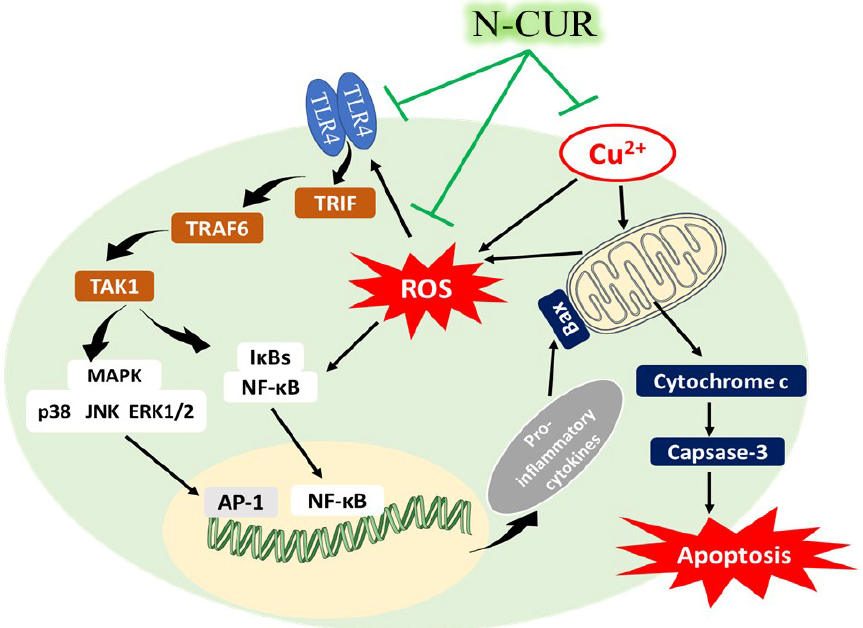
Figure 7. A schematic diagram illustrating the cardiotoxic effect of Cu and the protective effect of N-CUR. Cu elicits the generation of ROS and activates TLR4, NF- κ B and MAPKs, leading to the release of pro-inflammatory cytokines and apoptotic cell death. N-CUR prevented Cu-induced cardiac tissue injury by suppressing oxidative stress, inflammation and cell death, effects that were associated with suppression of TLR4/NF- κ B and MAPKs signaling.